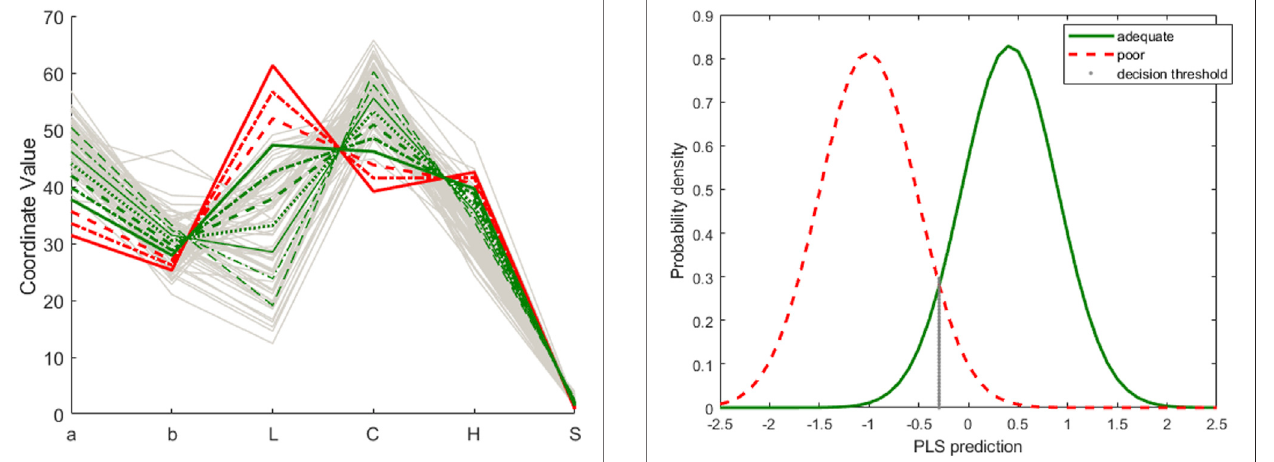
FIGURE 5 | Plastic pellets. Probability density functions of the normal distributions fi tted to the PLS predictions, red and dashed for the poor category, green for the adequate one. The vertical dotted line marks the decision threshold for equal sensitivity and speci fi city.